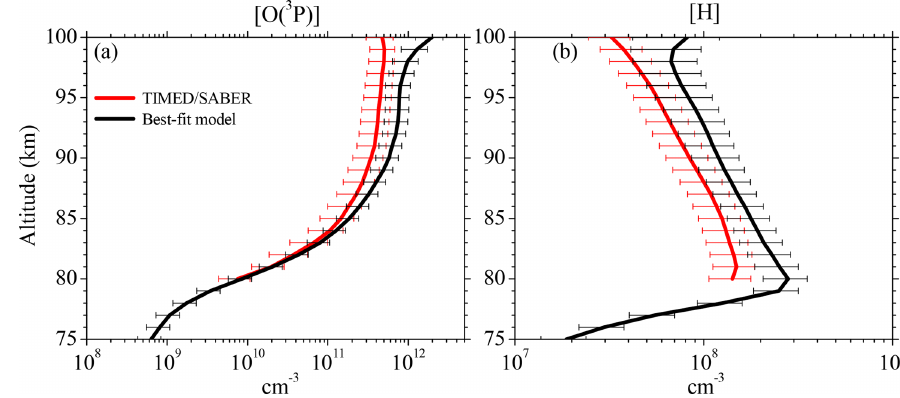
Figure 6. Vertical profiles of (a) [O ( 3 P ) ] and (b) [H] derived from the SABER OH(9-7) + OH(8-6) VER observations (Mlynczak et al., 2018) and our best-fit model by fitting the SABER OH(9-7) + OH(8-6) VER and OH(5-3) + OH(4-2) VER, as well as the SCIAMACHY OH(6-2) VER and OH(3-1) VER. Shown are averages of night-time mean zonal means of co-location measurements (see Sect. 2.2) from 2003 to 2011 between 0 and 10 ◦ N. Error bars show the 1 σ uncertainty due to chemical and physical processes.